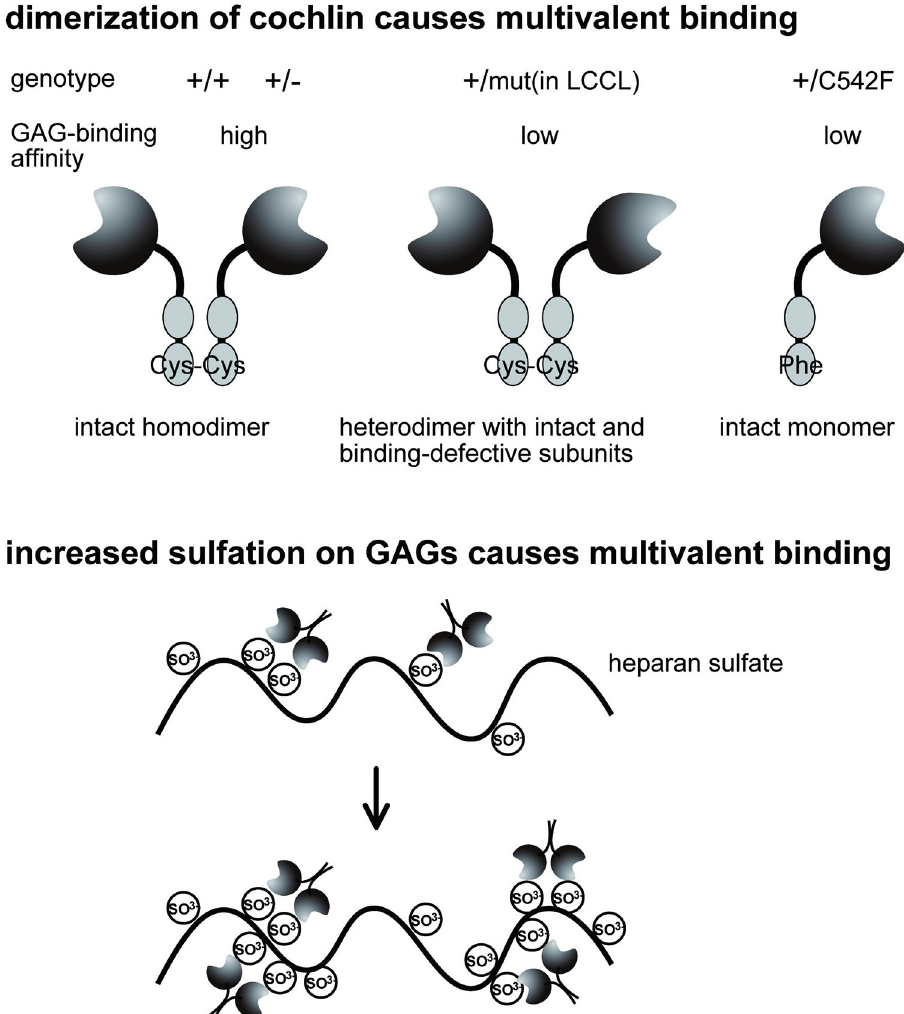
Fig 5. The effects of cochlin dimerization and GAG sulfation on their binding. GAG binding is maximized in wild- type cochlin homodimers (left). Dimers formed between wild-type cochlin and mutated cochlin (middle) as well as a cysteine substitution in cochlin (C542F) that inhibits dimer formation via a disulfide bridge (right) reduced cochlin’s GAG-binding ability. Given the age-dependent decrease of heparan sulfate/heparin contents and their sulfation levels, the interaction between cochlins and GAGs provide a possible mechanism for understanding autosomal dominant, late-onset hearing loss in DFNA9. Sulfation of GAGs is also involved in the interaction between cochlin and sulfated GAG because increased sulfation of GAGs presumably causes increased binding sites of